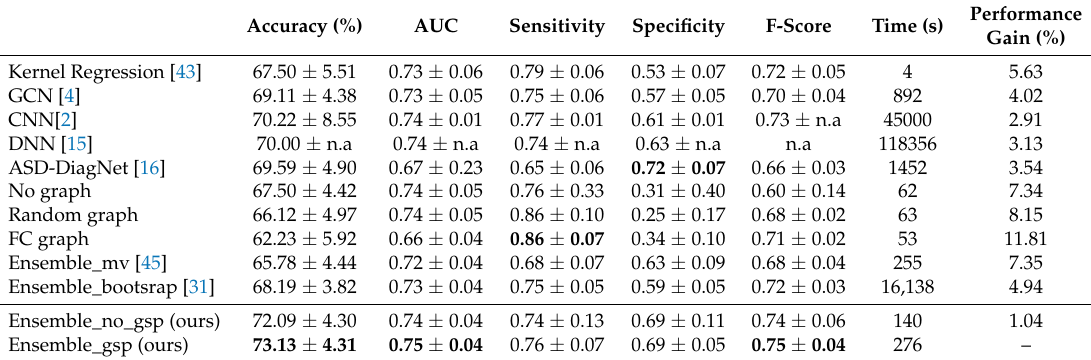
Table 2. Classification results of baselines and ablation studies. The results for Kernel Regression [43], GCN [4] and Ensemble_bootstrap [31] were calculated using our implementation. The performance gain of our model with respect to the given baselines is in terms of accuracy. The bold font shows the best performance. n.a stands for not